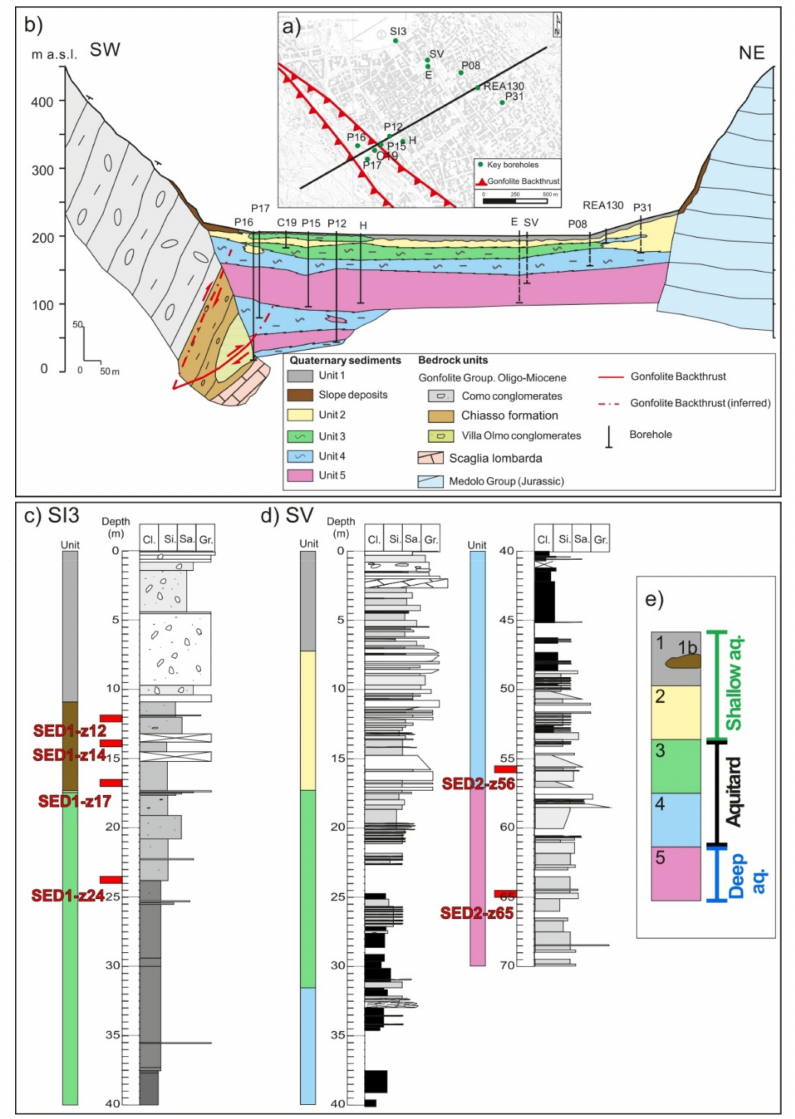
Figure 2. ( a ) Location of cores SI3 and SV discussed in the text as well as other cores used to provide subsurface control on the stratigraphy (please refer also to Figure 1b), and the trace of the geological cross-section shown in ( b ). ( b ) Geological cross-section south-west (SW)–north-east (NE) oriented, perpendicular to the sedimentary basin; vertical exaggeration ca. 2 × ; modified after [14]. ( c , d ) Stratigraphic log of cores SI3 and SV, and position of sediment samples. ( e ) Correlation among stratigraphic and hydrogeological